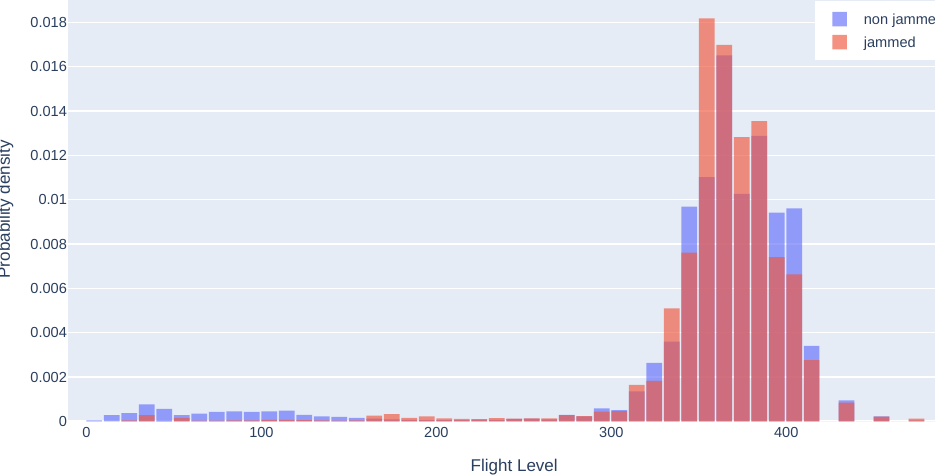
Figure 7. Altitude distribution of all traffic (blue) vs. traffic affected by RFI (red) in